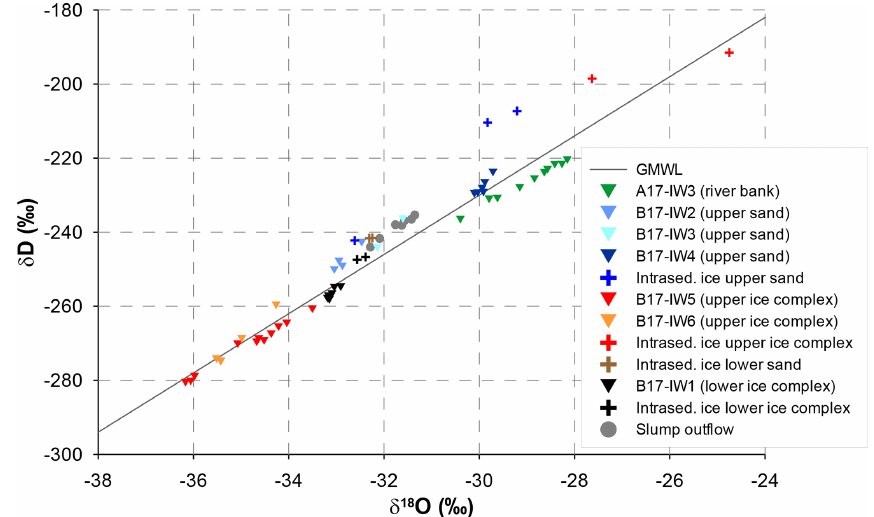
Figure 6. Co-isotopic δ 18 O– δ D diagram of ice wedges and intrasedimental ice sampled at the Batagay megaslump and the Adycha River. The data from the Batagay megaslump outflow samples record an integrated signal of the entire Batagay permafrost sequence and modern